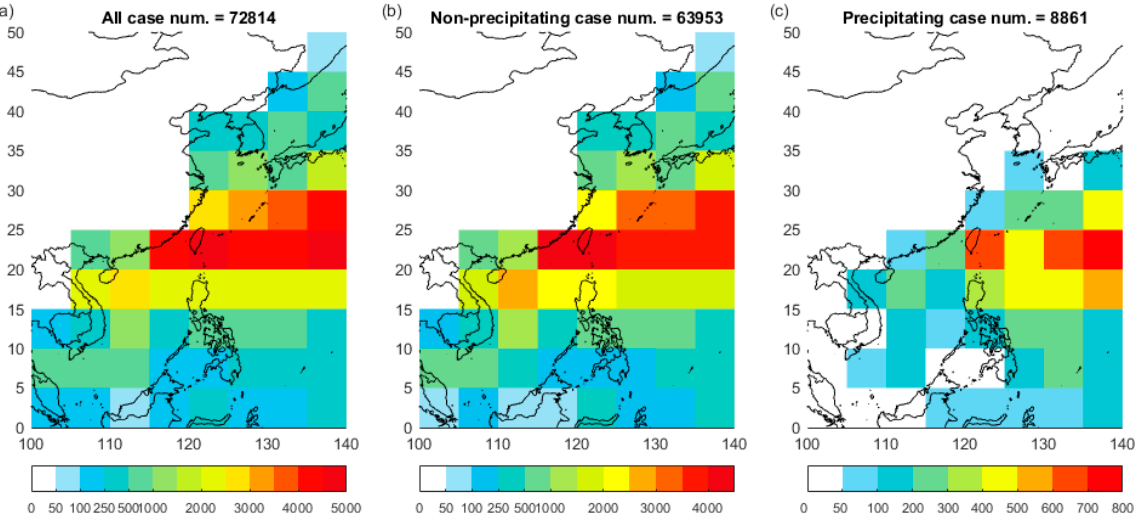
Figure 3. Spatial distribution of the marine warm cloud pixels: ( a ) All, ( b ) Non–precipitating, ( c ) Precipitating.